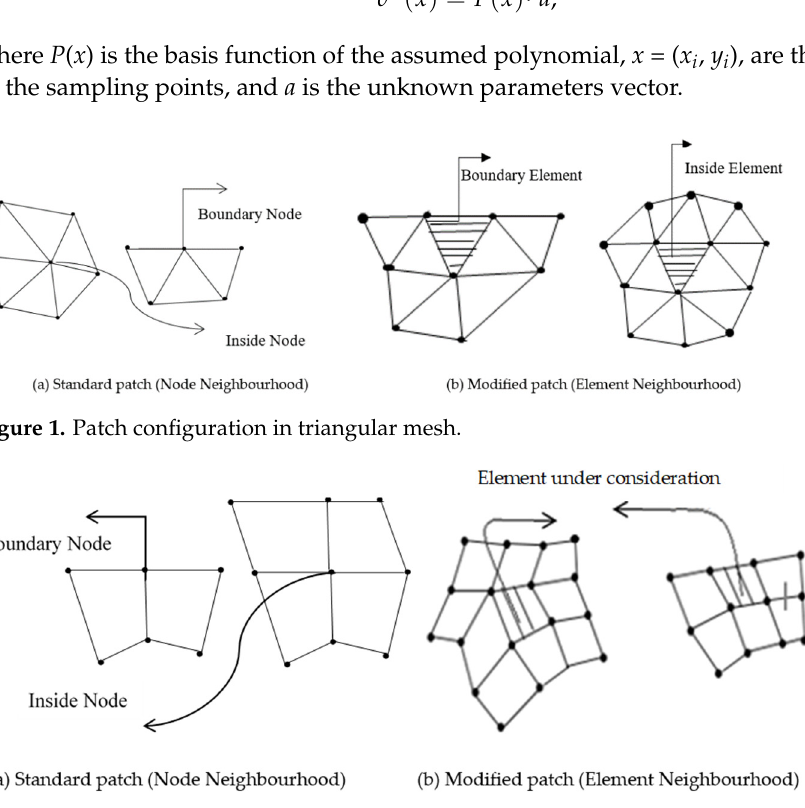
Figure 2. Patch configuration in quadrilateral mesh.